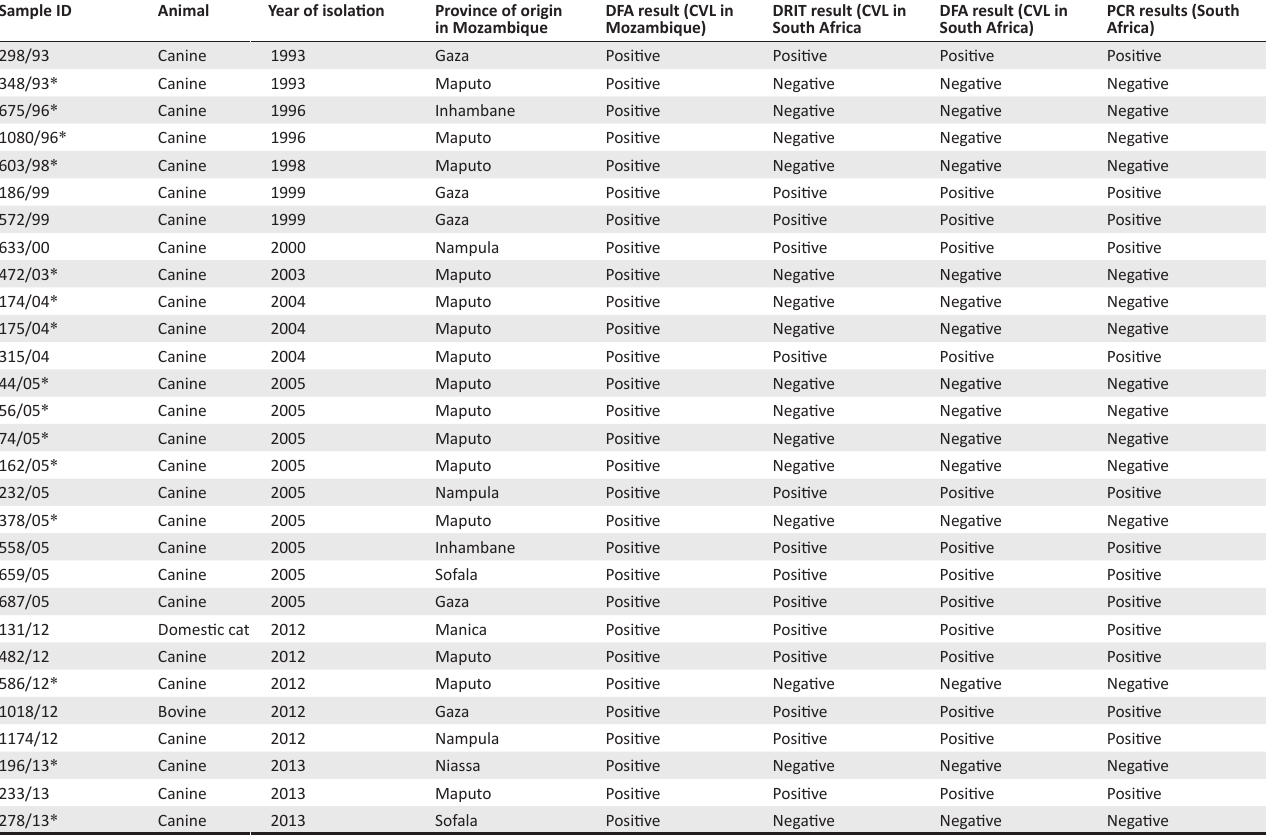
TABLE 1: Neuronal tissue sample cohort from Mozambique depicting the initial diagnostic results from the Central Veterinary Laboratory in Maputo, Mozambique, the diagnostic discrepancies and their independent antigenic and molecular confirmation at the Agricultural Research Council-Onderstepoort Veterinary Institute in South Africa. Sample ID